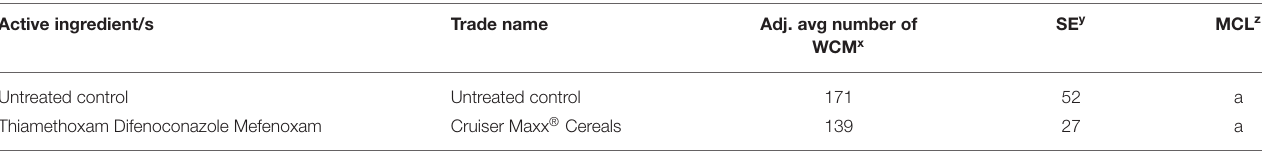
TABLE 5 | Effect of neonicotinoid seed treatment on average WCM total per plant. Active